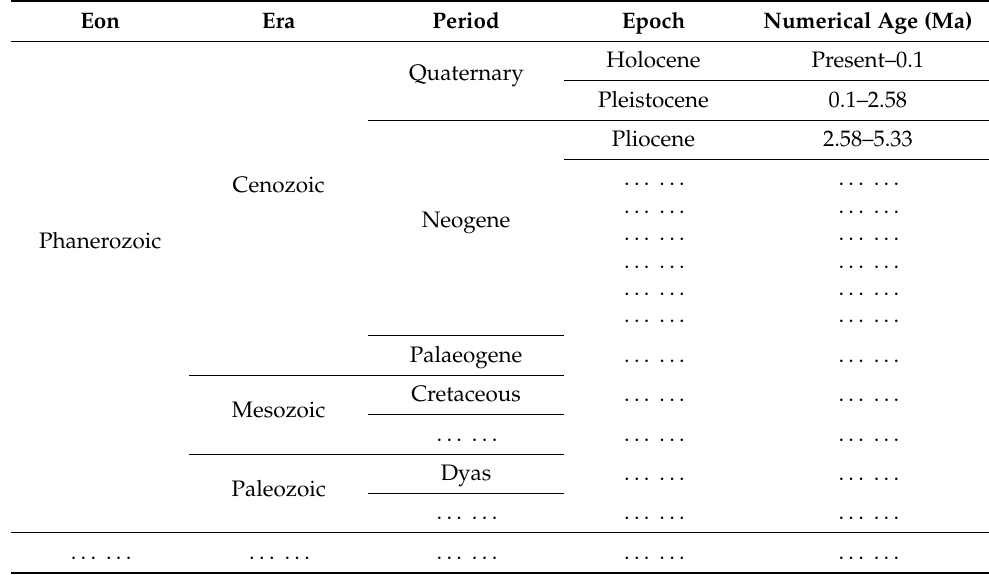
Table 3. Temporal reference coordinate system of the geological tectonic evolution (part). Eon